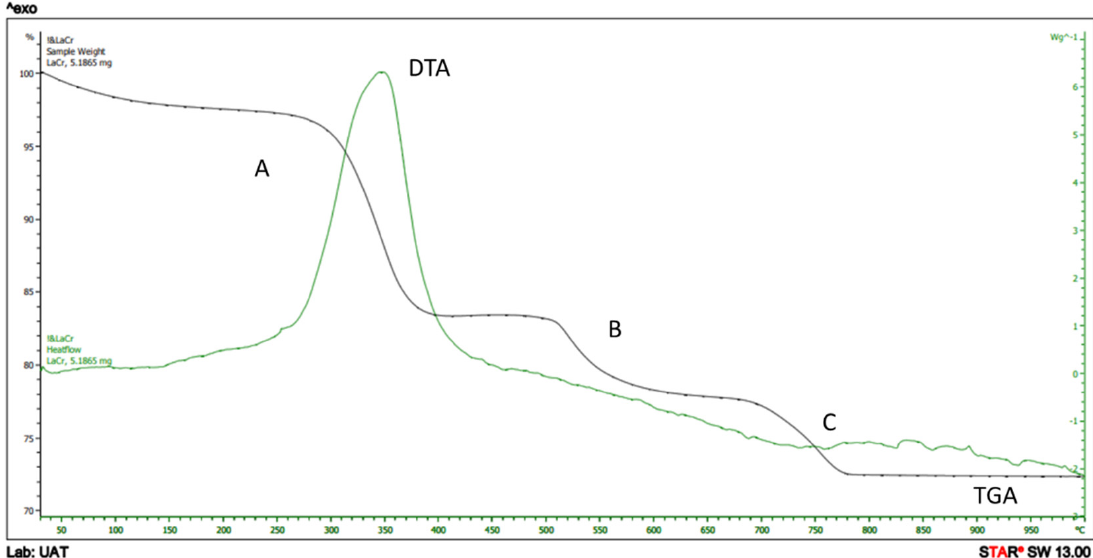
Figure 3. TG/DTA curves of the powder precursor of LaCrO 3.